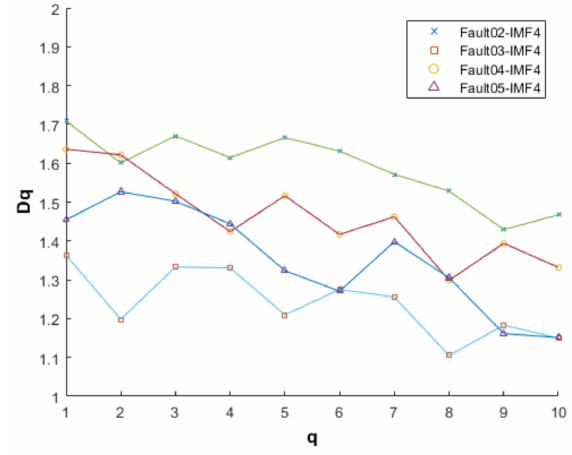
Figure 23. IMF4‑EMD box fractal dimension map.